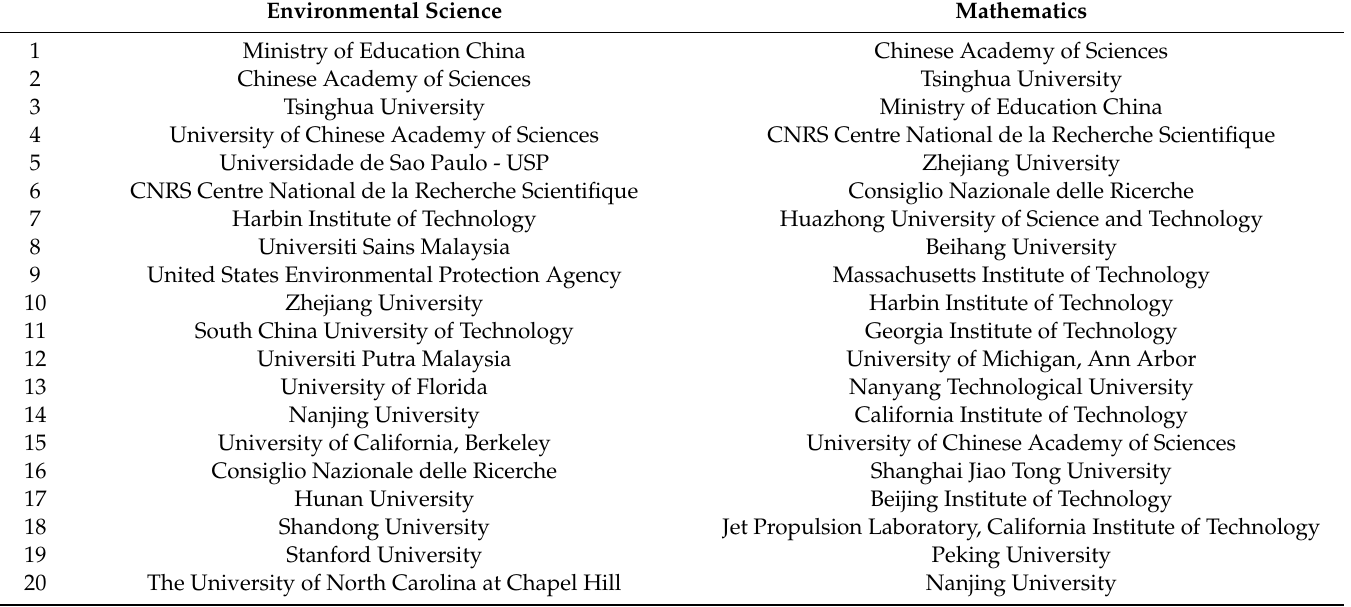
Table 7. Worldwide publications by a ffi liation / university on low cost for the categories from 9 to 10. Environmental